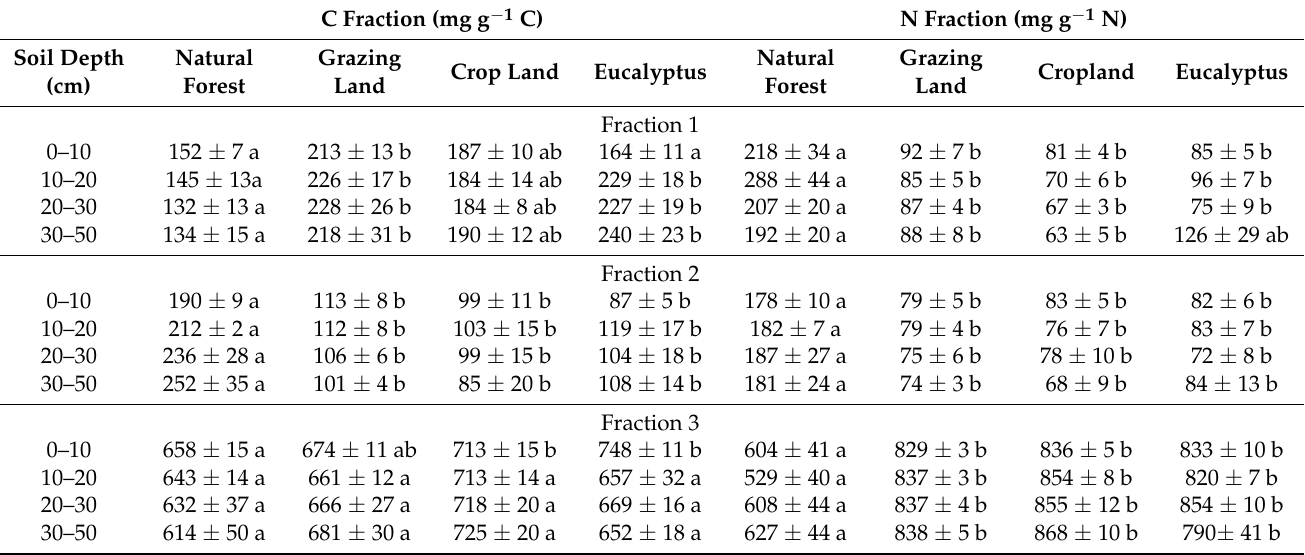
Fraction 1, 2 and 3 indicate labile 1, labile 2 and recalcitrant substances, respectively.